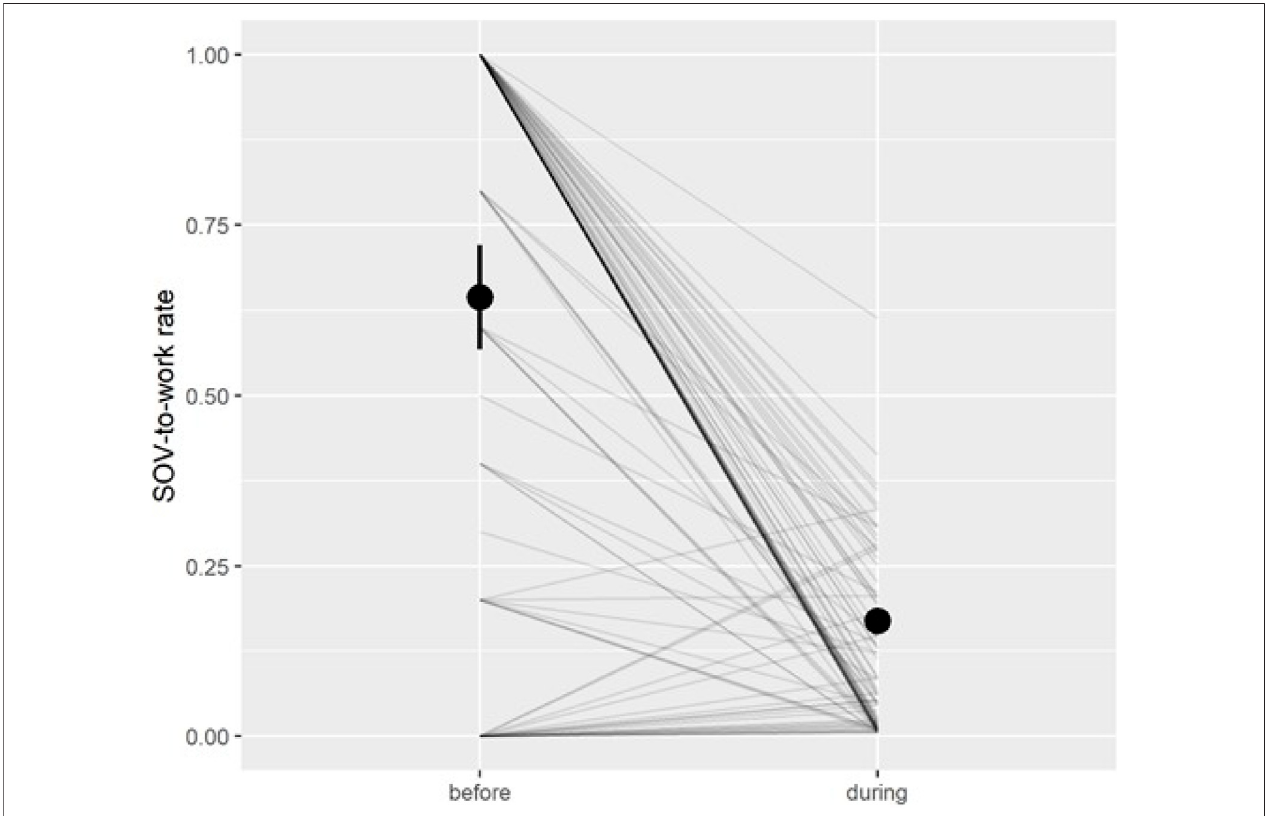
FIGURE 13 | Model predicted SOV-to-work rate of bike-lending participants by intervention phase from survey (before) and trip logs (during).